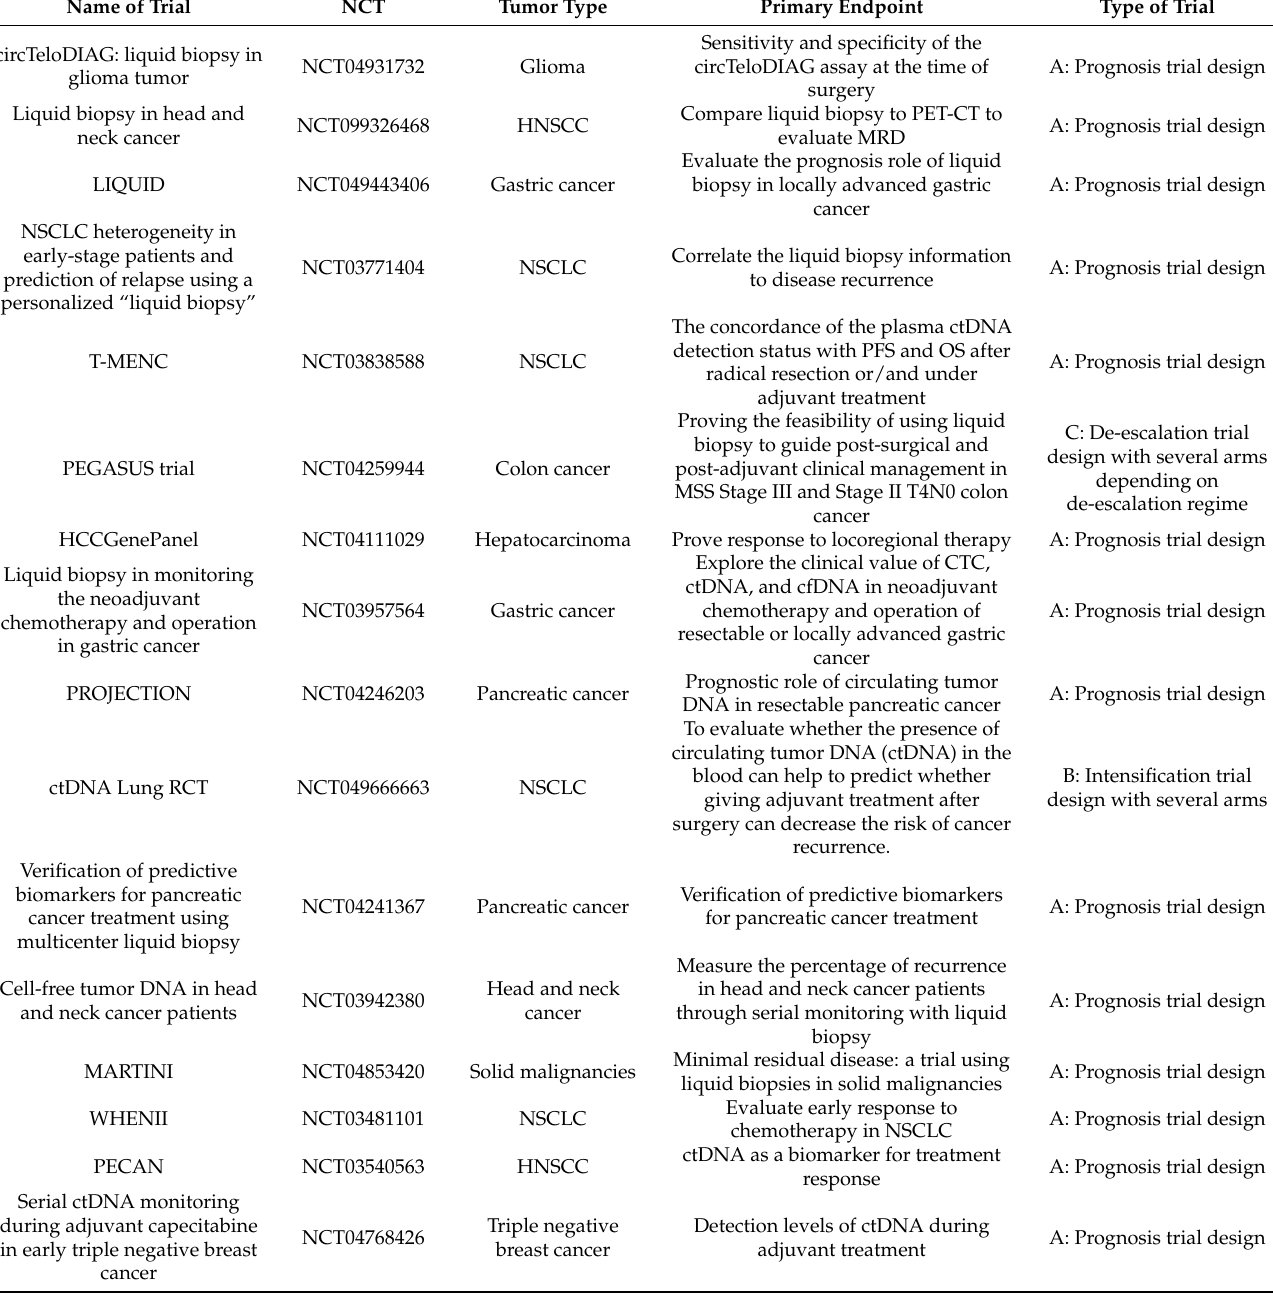
Table 3. Non-exhaustive list of ongoing trials based on ctDNA